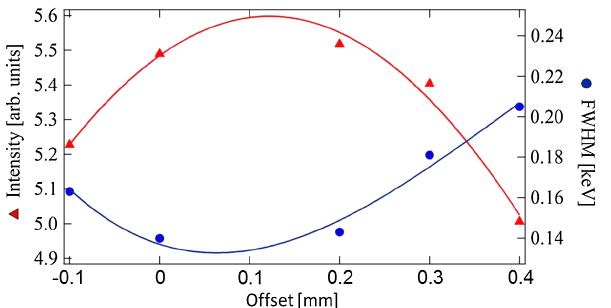
FIG. 24. Intensity and Full Width Half Maximum (FWHM) of the 11th harmonic as a function of the offset that varied from 0.3 mm up to 0.8 mm.